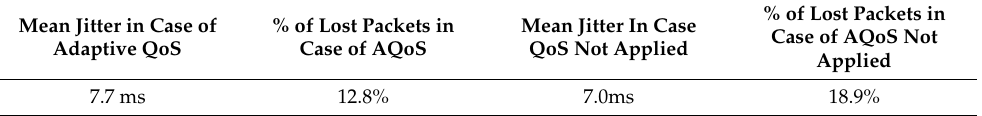
Figure 15. Throughput obtained in Scenario 3 in case of applying and without applying proposed adaptive QoS model for 120-seconds BE traffic flow ( a ) Throughput obtained in Scenario 3 in case of applying proposed model, ( b ) Throughput obtained in Scenario 3 without applying proposed adaptive QoS model. Table 13. Scenario 3 Performance Results in case of 4-parallel video streaming